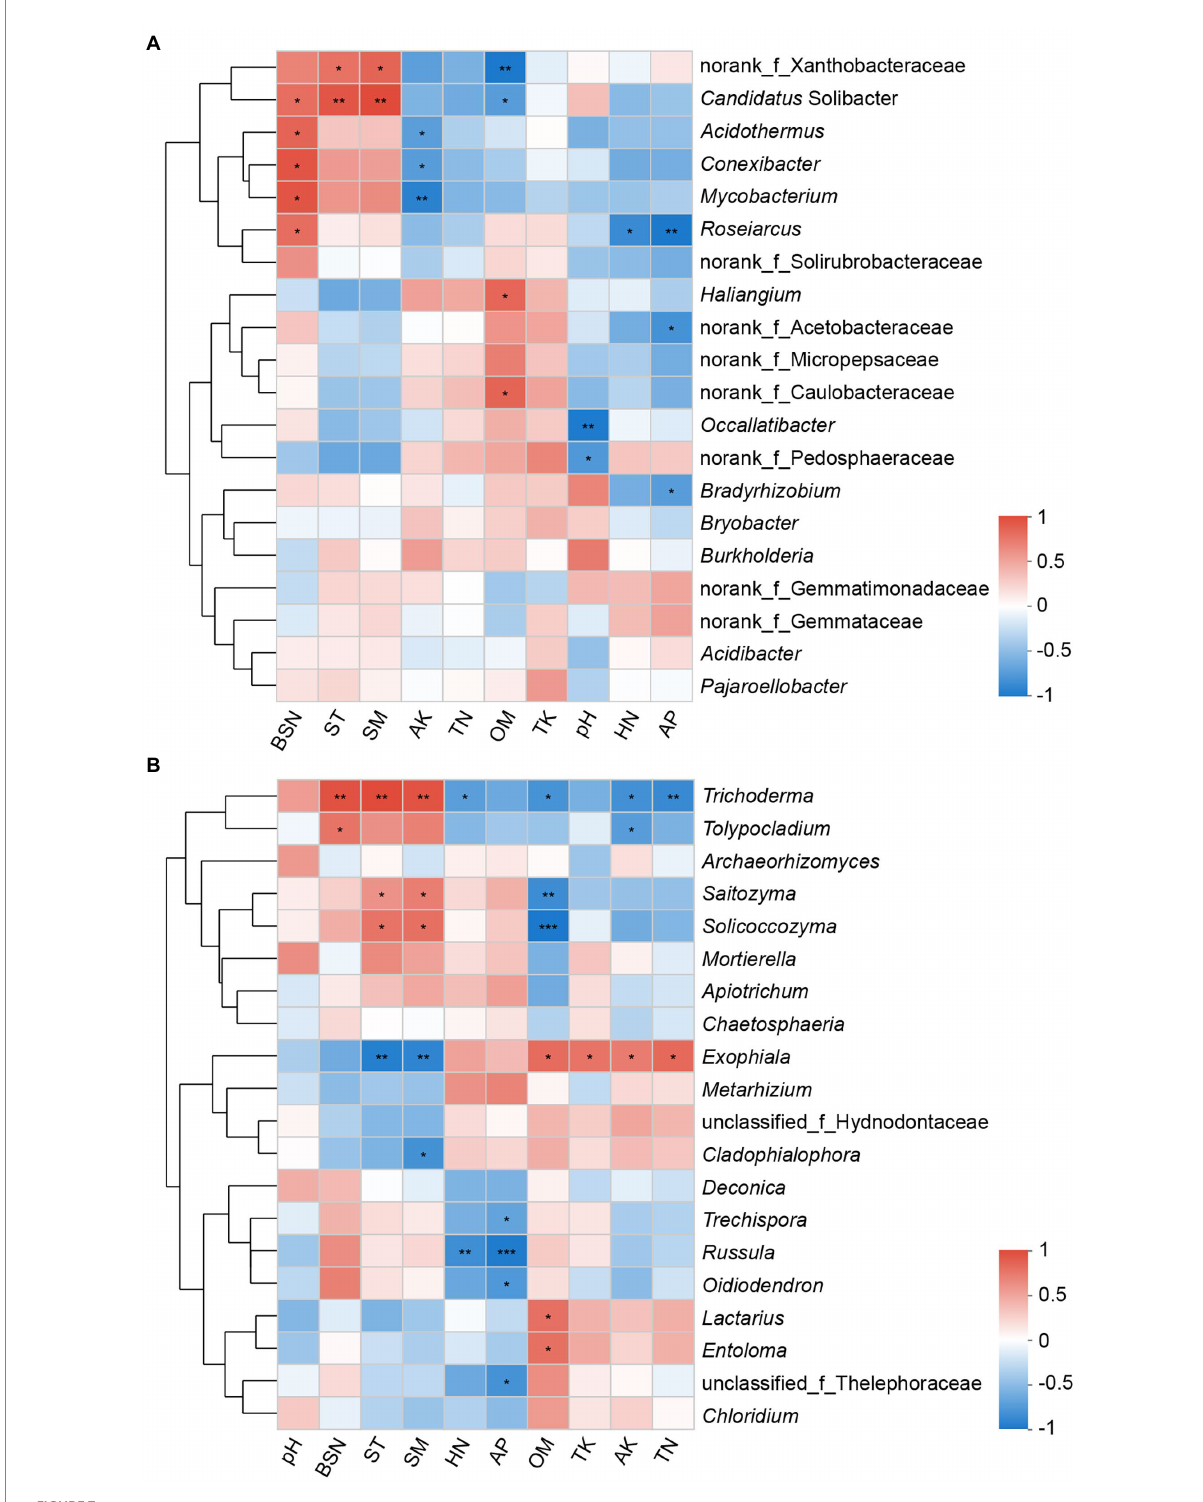
FIGURE 7 Heatmaps showing correlations between chosen factors and the first 20 genera of bacteria (A) and fungi (B) . Color depth represented the magnitude of correlation R value. *0.01 < p ≤ 0.05; **0.001 < p ≤ 0.01; *** p ≤ 0.001; BSN, bamboo shoot number; ST, soil temperature; SM, soil moisture; AK, available potassium; TN, total nitrogen; OM, organic matter; TK, total potassium; HN, hydrolyzable nitrogen; AP, available